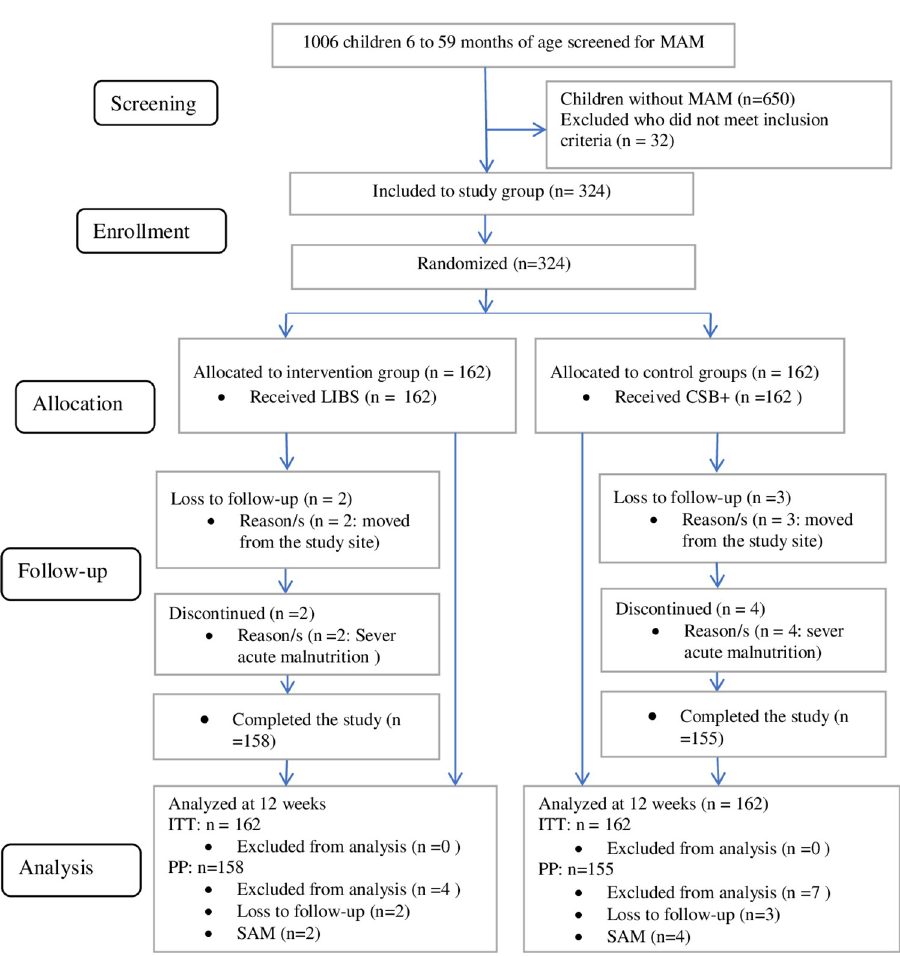
Fig 1. Flowchart of study enrollment to completion. Screened for MAM, children aged 6 to 59 months who screened for moderate acute malnutrition; Children without MAM, children aged 6 to 59 months who did not have moderate acute malnutrition; Randomized children aged 6 to 59 months who were assessed positive for moderate acute malnutrition, fulfilled the inclusion criteria, were recruited and randomly allocated; The loss to follow-up, children who were randomly allocated to intervention and control groups and stopped participating in the study at any stage of the study; Discontinued due to SAM, children who were randomly allocated to intervention and control groups and discontinued from the study at any stage of the study; Analyzed at 12 weeks, children aged 6 to 59 months whose information was analyzed at 12 weeks; ITT and PP analysis are done. Abbreviations: MAM: moderate acute malnutrition; LIBS: local-ingredients-based supplement; CSB+: corn-soy blend plus; SAM: severe acute malnutrition; ITT: intention to treat; PP: per-protocol. The daily weight gain was similar in both groups. In ITT analysis, the mean weight gain (SD) among children in the LIBS group was 3.18 (1.89) g/kg/day, whereas the mean weight gain (SD) among children in the CSB+ group was 3.09 (2.05) g/kg/day (p = 0.642) The PP analysis showed that the mean weight gain (SD) among children in the LIBS group was 3.25 (1.86) g/kg/day, whereas the mean weight gain (SD) among children in the CSB+ group was 3.21 (1.98) g/kg/day (p = 0.838). Both ITT and PP analyses showed that LIBS group was non- inferior compared with the CSB+ group (predefined non-inferiority margin of risk difference = -1.3 g/kg/d) [ITT risk difference = 0.10 (95% CI: -0.33, 0.53); PP risk difference = 0.04 (95% CI: -0.38, 0. 47)] (Fig 3 and Table 3) . The ITT analysis showed that the mean MUAC gain (SD) for the LIBS group was 0.12 (0.07) mm/day and 0.11 (0.08) mm/day for the CSB+ group.